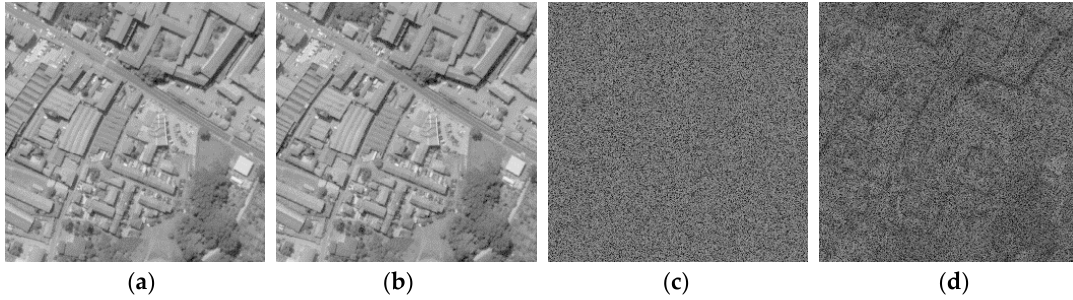
Figure 1. The snapshot of the ROSIS (Reflective Optics Imaging Spectrometer) dataset Pavia Centre in the 15th band. The ratio of the signal-dependent (SD) noise power to the signal-independent (SI) noise power is 1:1: ( a ) noise-free dataset; ( b ) dataset with 30 dB noise; ( c ) the SI noise; ( d ) the SD noise.